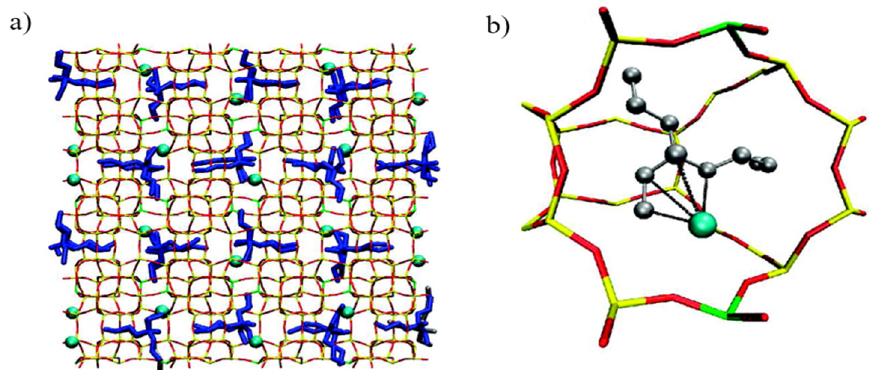
Figure 6. ( a ) Adsorption arrangement of 4–ethyl–4–methyloctane molecules (S/R gas ratio = 7:3) in zigzag and straight channel with Al-5(Ca 2+ ). S/R-enantiomers are colored blue and gray, respectively. The blue spheres indicate Ca 2+ cations. ( b ) Magnified image of enantioselective adsorption at a specific intersection; the colors represent oxygen (red), silicon (red), and aluminum (green) Reprinted with permission from [85] Copyright 2010 American Chemical Society.